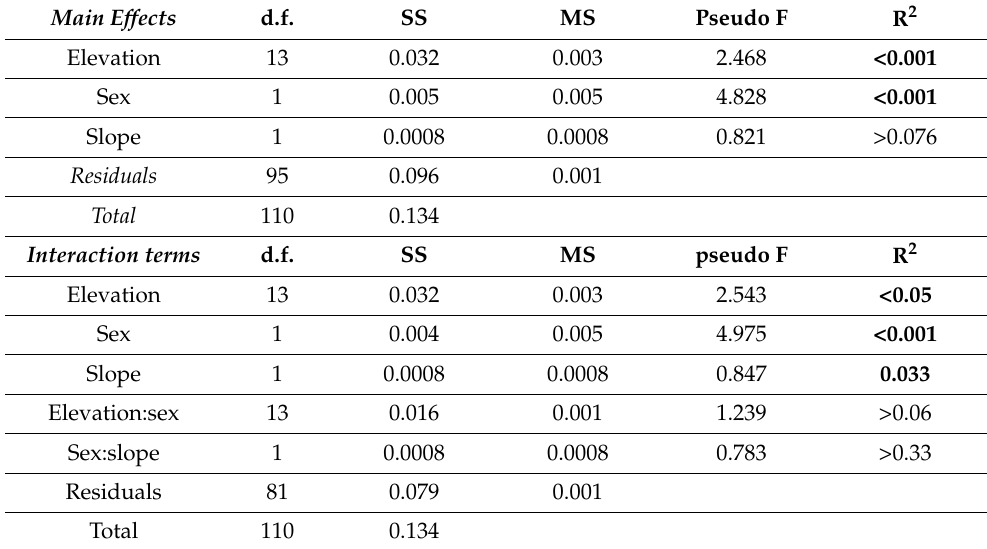
Table 1. PERMANOVA results (Adonis [20]; 9999 permutations) for geometric morphometric data and explanatory variables (sex, elevation, slope) and their double interaction based on Euclidian distances. (Abbreviations: SS–sum of squares, MS–mean sum of squares, d.f–degrees of freedom).